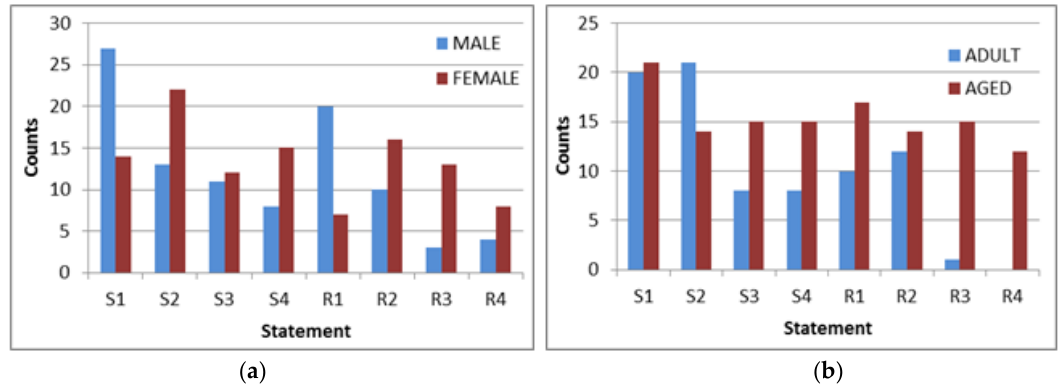
Figure 12. Retrospective verbal protocol results: ( a ) sentence counts between males and females and ( b ) age-related effects on verbal counts.